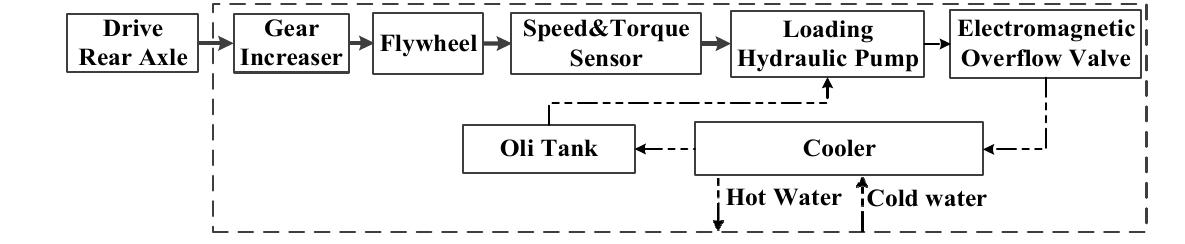
Figure 6. Schematic diagram of the load system. Table 8. Type and parameters of the main components of the load system.